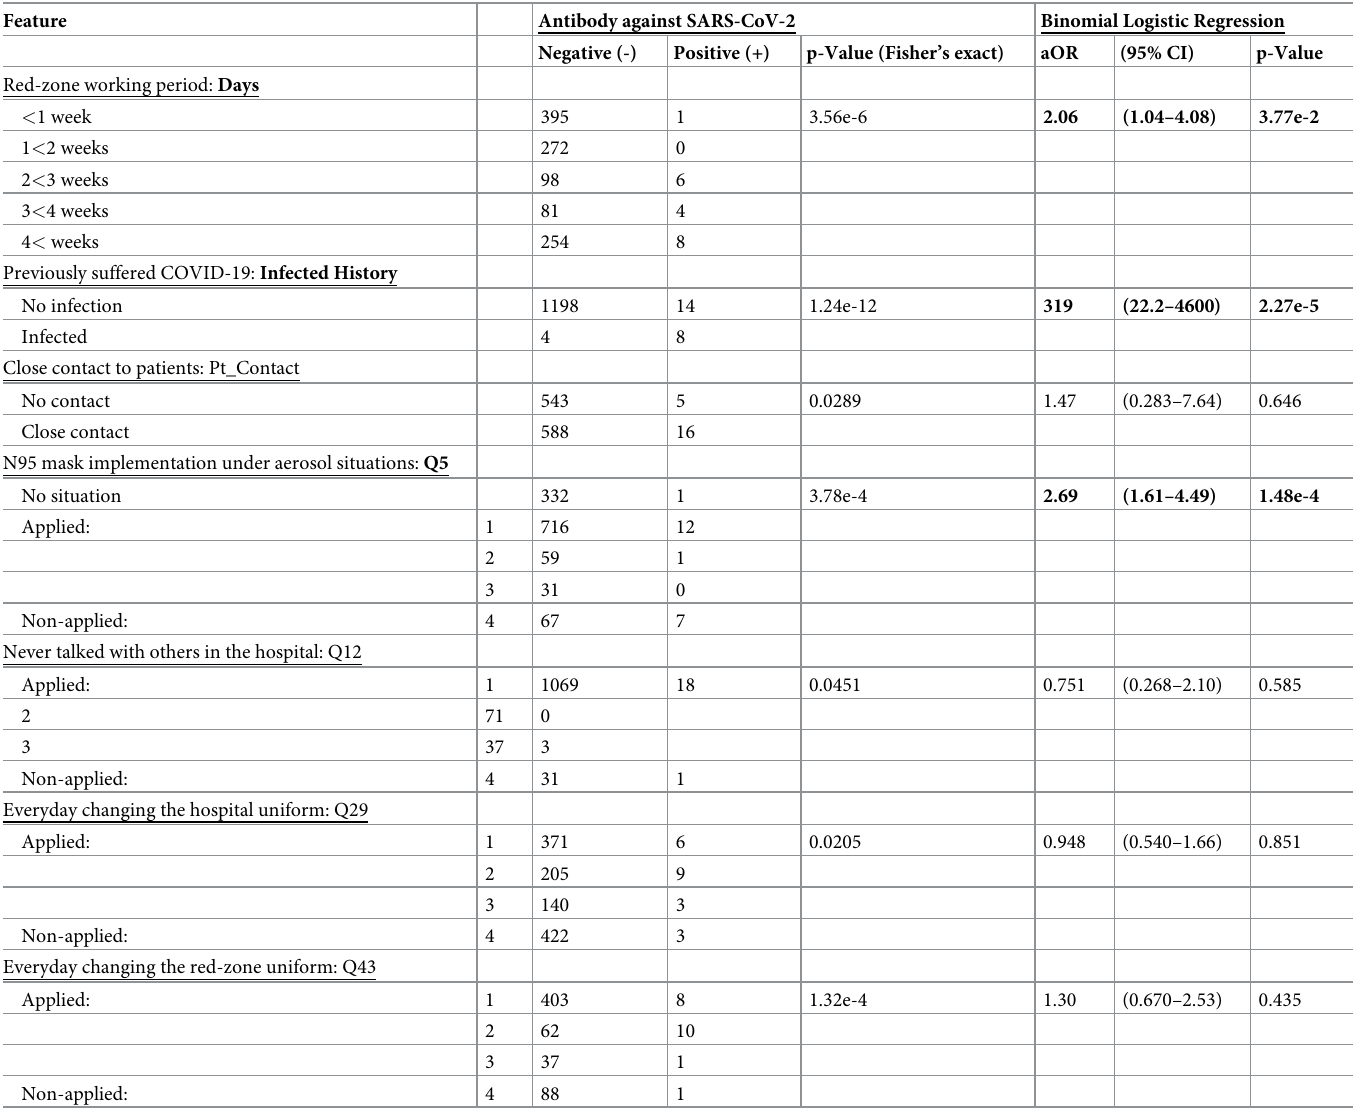
Table 2. Individual characteristics and seroprevalence of